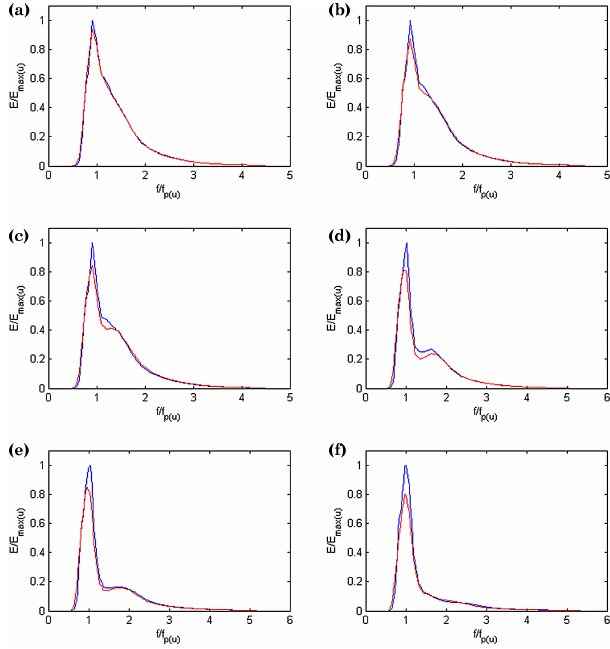
Figure 21. Modelled 1-D spectrum in the Moray Firth wave gauge, the red line is the coupled model (with WCIs incorporated), while the blue line is the uncoupled model: (a) 31 March 2010 at 00:30, (b) 31 March 2010 at 01:15, (c) 31 March 2010 at 02:00, (d) 31 March 2010 at 04:15, (e) 31 March 2010 at 06:00, and (f) 31 March 2010 at 08:30UTC.